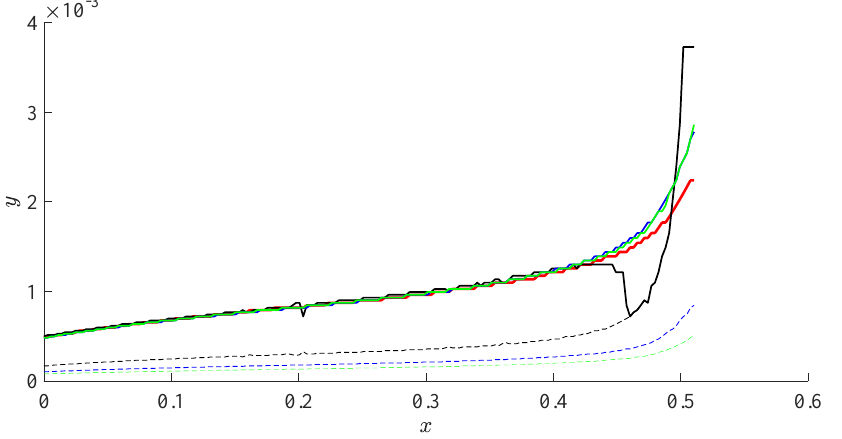
Figure 4. The function y BL ( x ) at tol H = 10 − 6 (red), and the functions ∆ v ( x ) (black), ∆ s ( x ) (blue), ∆ u ( x ) (green) at optimal values of adjustable constants c v , c s , c u (solid line) and at c v = c s = c u = 0 (dashed line) for the slice at the prolate spheroid in Figure